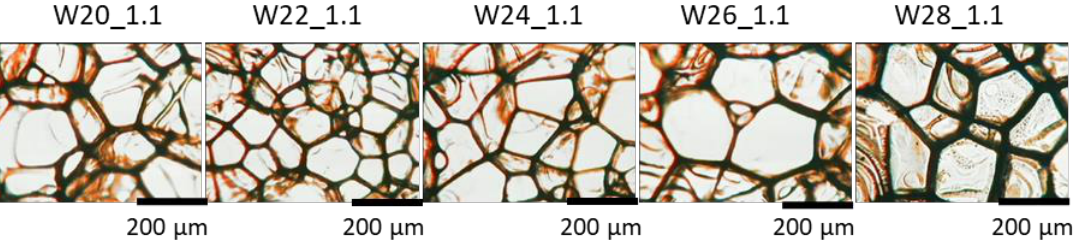
Figure 4. The cellular structure of the foams modified with different amounts of the water as foaming agent examined with the use of an optical microscope. Table 3. Characteristics of the cell structure of PU foams.